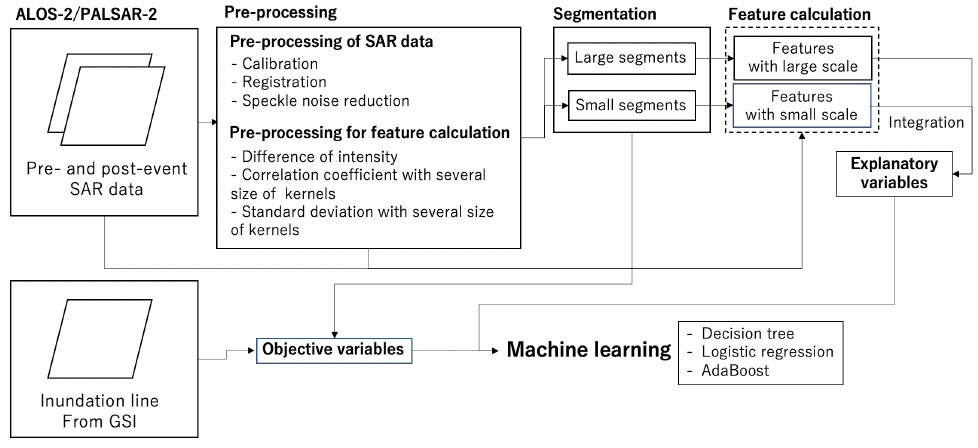
Figure 3. General overview of the